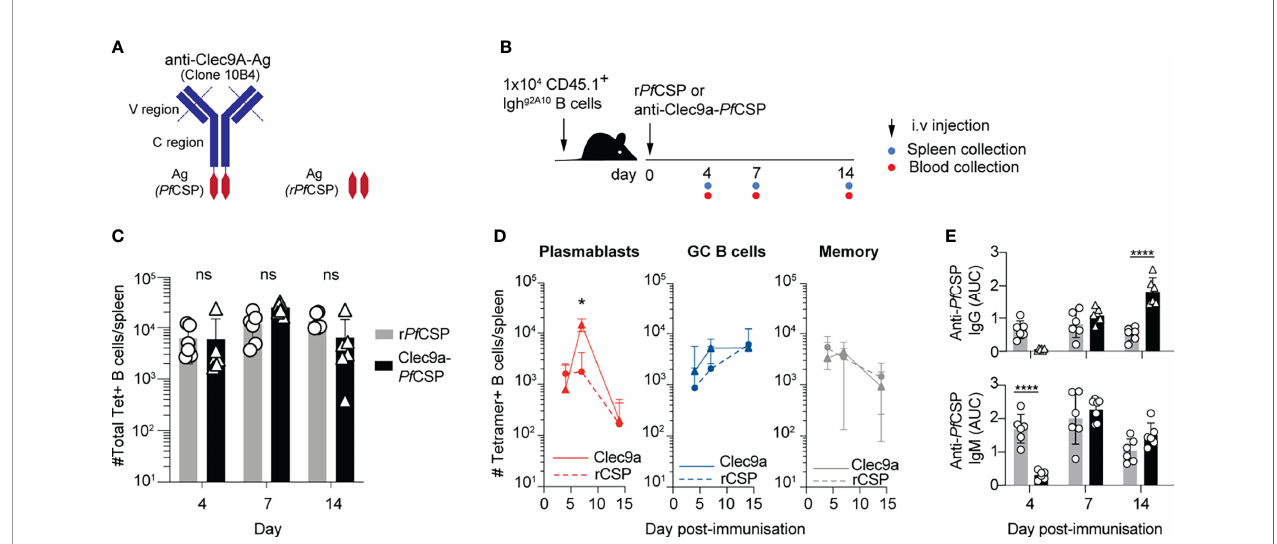
FIGURE 8 | Targeting DCs for antigen presentation promotes the early plasmablast response. C57BL/6 mice received 1x10 4 Igh g2A10 cells prior to immunization with r Pf CSP (2 m g) oranti-Clec9A- Pf CSP (10 m g) and assessment of B cellandantibody response at days4,7 and 14 post-immunization. (A) Schematicof Clec9A conjugated to Pf CSP. (B) Schematicofexperimentalprotocol. (C) Total number ofresponding Igh g2A10 B cells following immunization with anti-Clec9A- Pf CSP orrecombinant Pf CSP (r Pf CSP). (D) Number of Igh g2A10 B cells ofthe plasmablast (PB), germinal centre (GC) and memory phenotype after immunization. (E) Serum levelsofIgM and IgG anti- Pf CSP antibodies post-immunization,quanti fi edby ELISA and presented as area under the curve (AUC). Data pooled from 2 independent experiments, with 3-4 mice per group. All statistical analyses performed bya linear mixedmodel incorporatingday and immunization inthe model as fi xedeffects, with individual experiments blocked to account for randomvariation.Abbreviationsfor p values are: ns, not signi fi cant; p < 0.05 = *;p < 0.0001 =